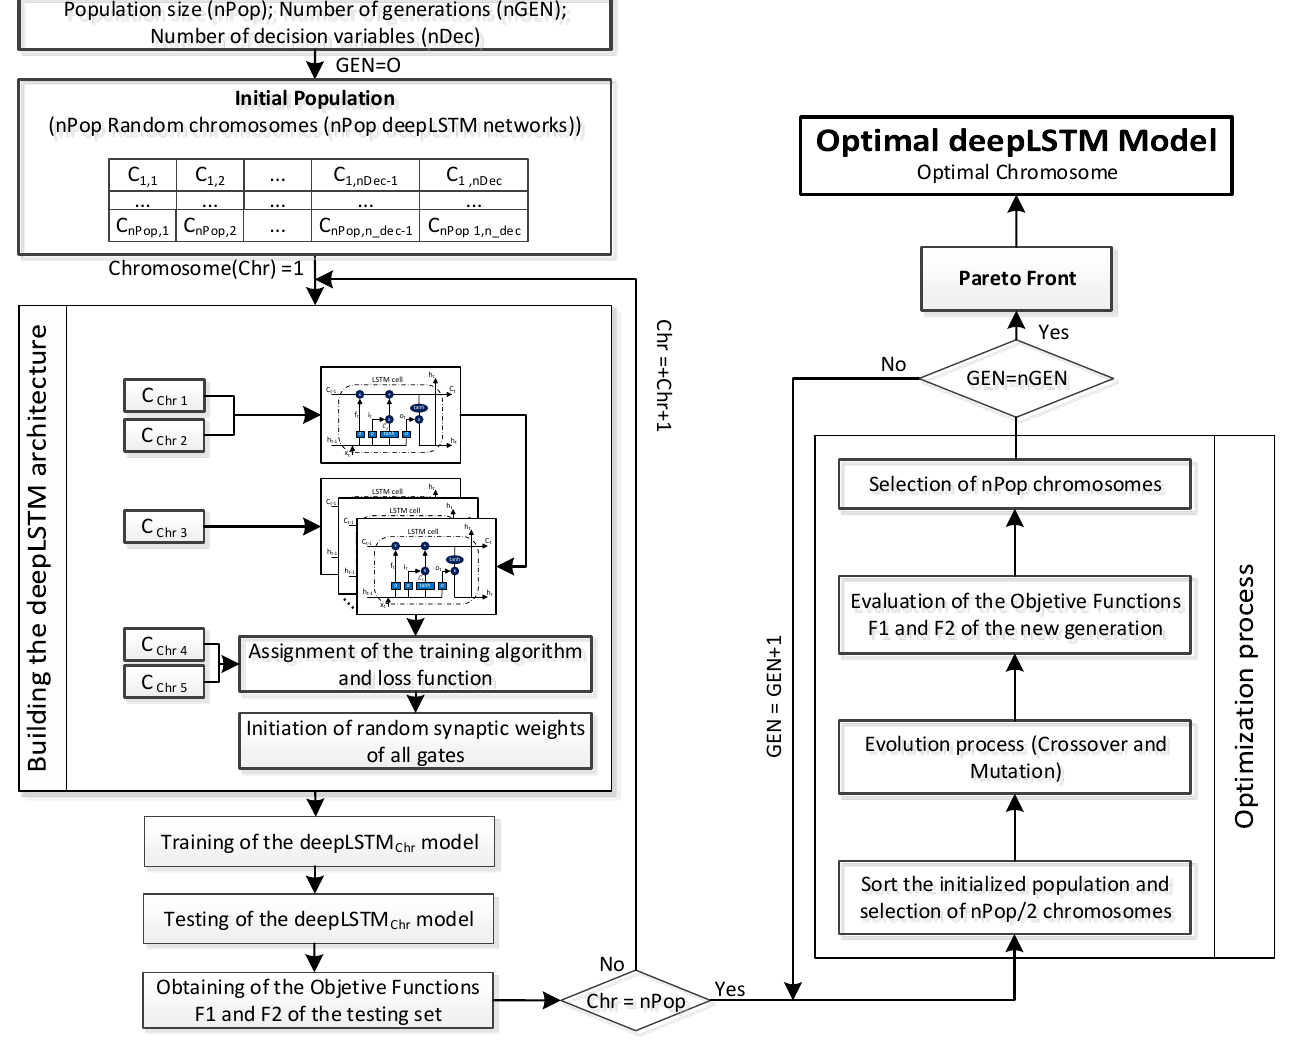
Figure 3. Flowchart of the PREPOSOL building and its optimization process. Table 1. Decision variables (genes) of the optimization